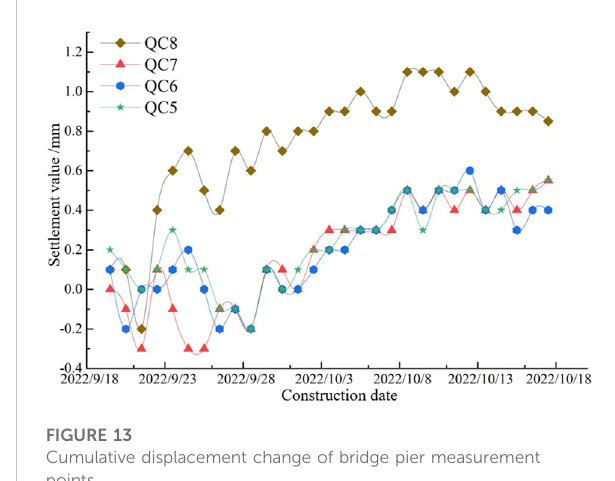
FIGURE 13 Cumulative displacement change of bridge pier measurement points.